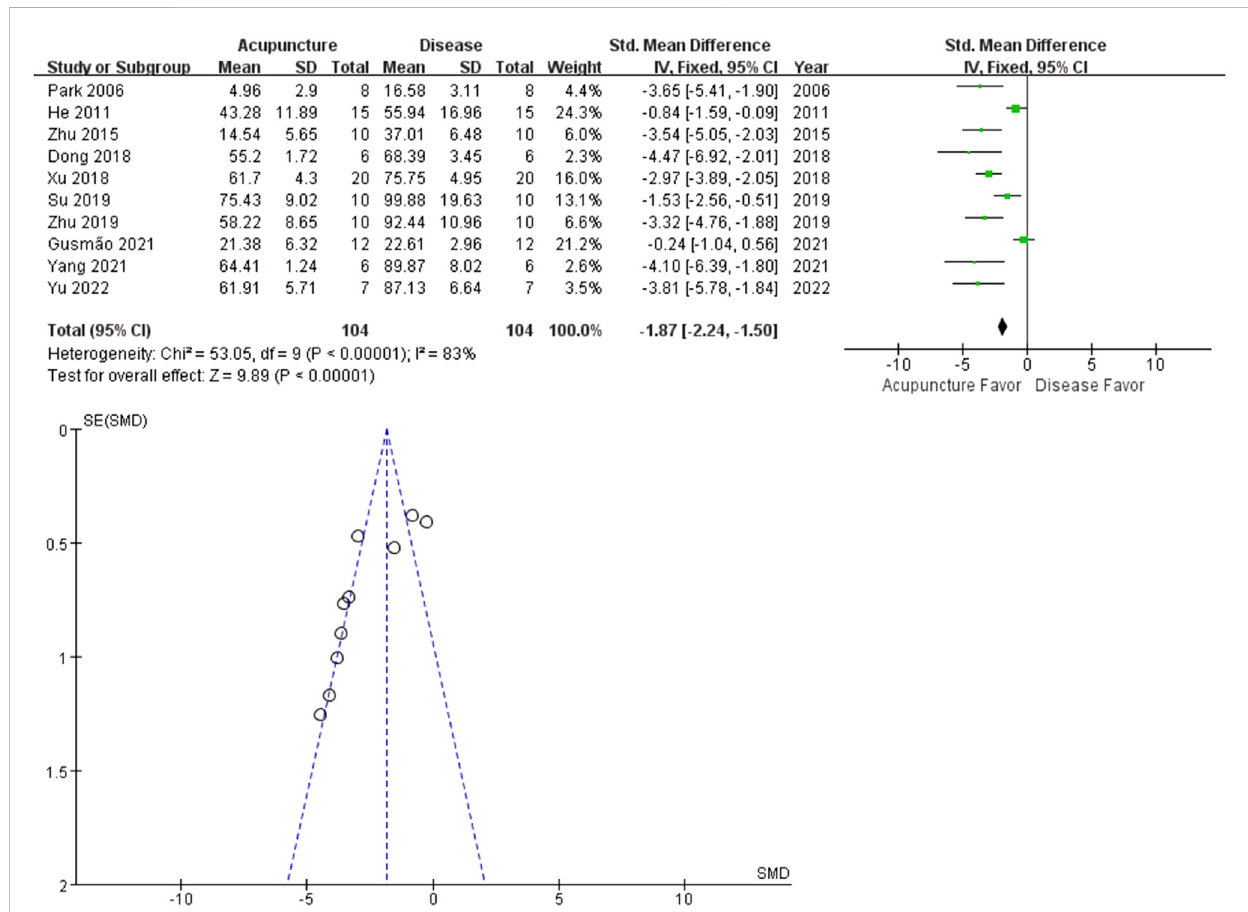
Meta-analysis comparing percentage increase in paw volume between the disease group and the acupuncture-treated